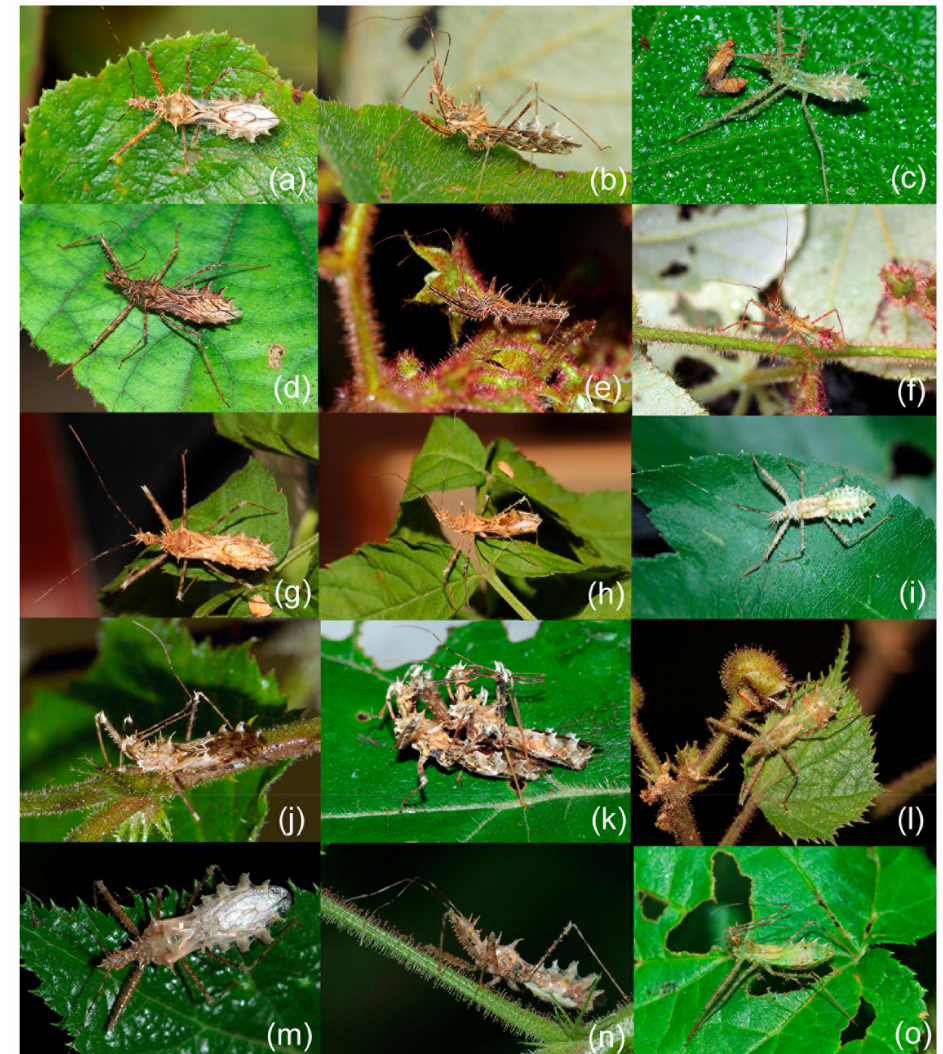
Figure 6. ( a – c ) Sclomina erinacea Stål, 1861, GZLS; ( d – f ) Sclomina guangxiensis Ren, 2001, GXLZ; ( g – i ) Sclomina parva sp. nov., SXYX; ( j – l ) Sclomina xingrensis sp. nov., GZXR; ( m – o ) Sclomina pallens sp. nov., GZTL. ( a , b , d , e , g , h , j , k , m , n ) adult; ( c , f , i , l , o ) nymph. Diagnostic characters: Body brown in adult, green in nymph, oblong ellique; body covered with numerous long spines and short tubercles. Head dorsally with two pairs of long spines behind antennal base and a pair of short spines behind ocelli; anteclypeus medial with two long spines and maxillary lateral, each with a short spine; first visible rostral segment sub-equal to one-half of second segment; first antennal segment sub-equal to head and pronotum together in length. Anterior angles of pronotum short spine-shaped; anterior pronotal lobe with four pairs of spines, posterior lobe with four strong spines; pro-pleuron of thorax and lateral margin of pronotum, Y-shaped ridge of scutellum with some little tubercles; pro-sternum of thorax lateral, each with a pair of short spines. Femora armed with spines and tubers; fore femur thickened, fore tibiae shorter than fore femur. Connexivum of abdomen laterally expended, posterior lateral angle obviously laterally produced, especially fourth to sixth